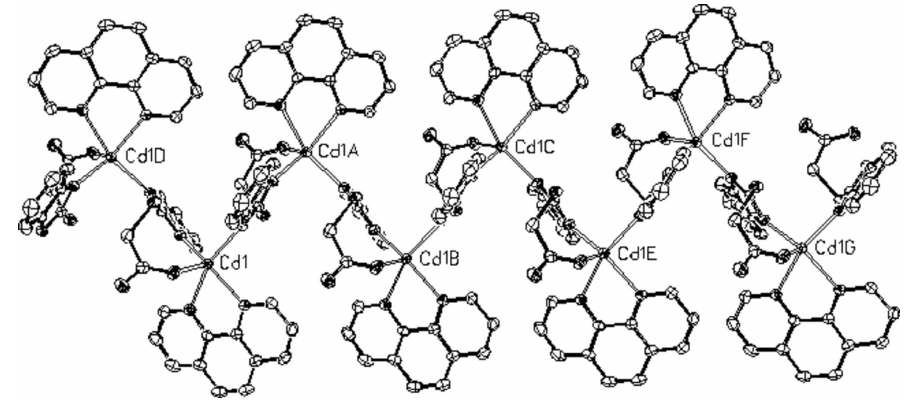
Figure 1 The one-dimensional chain of the title compound. Displacement ellipsoids are shown at 50% probability and H atoms are omitted for